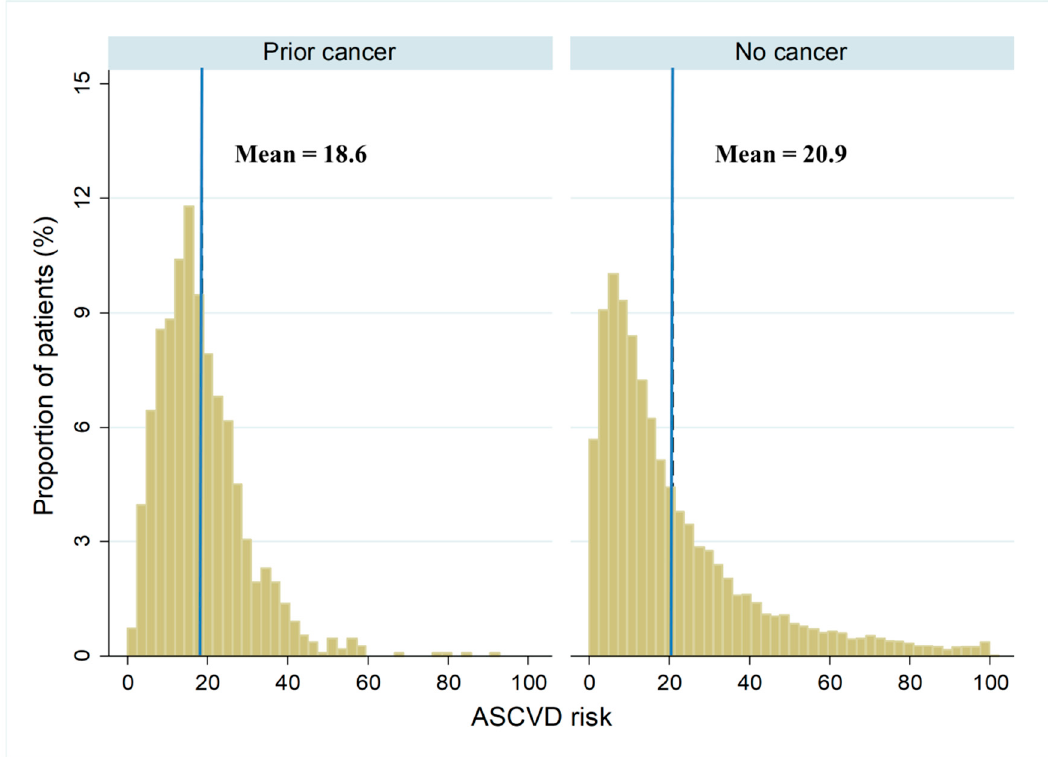
Figure 2. Distribution of age-standardized ASCVD risk by cancer status. The distribution of ASCVD risk classified according to cancer status after adjusting the age structure of the prior cancer group to the no cancer group with mean ASCVD risk indicated by vertical line. ASCVD: atherosclerotic cardiovascular disease.